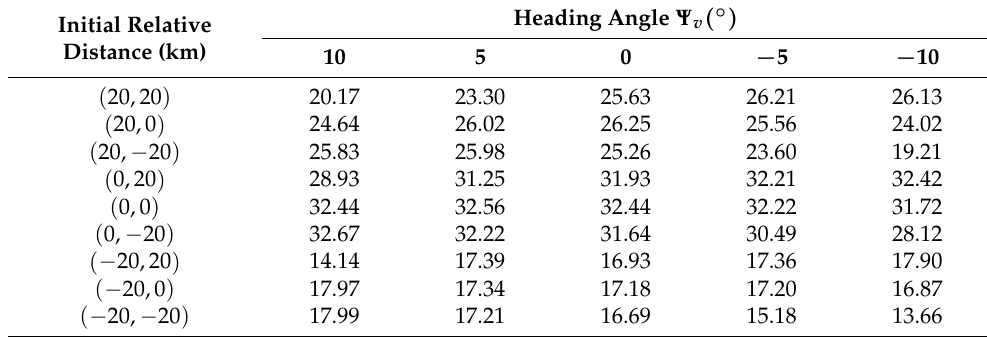
Table 6. Miss distance (m) with initial flight path angle ( θ = 5 ◦ ).